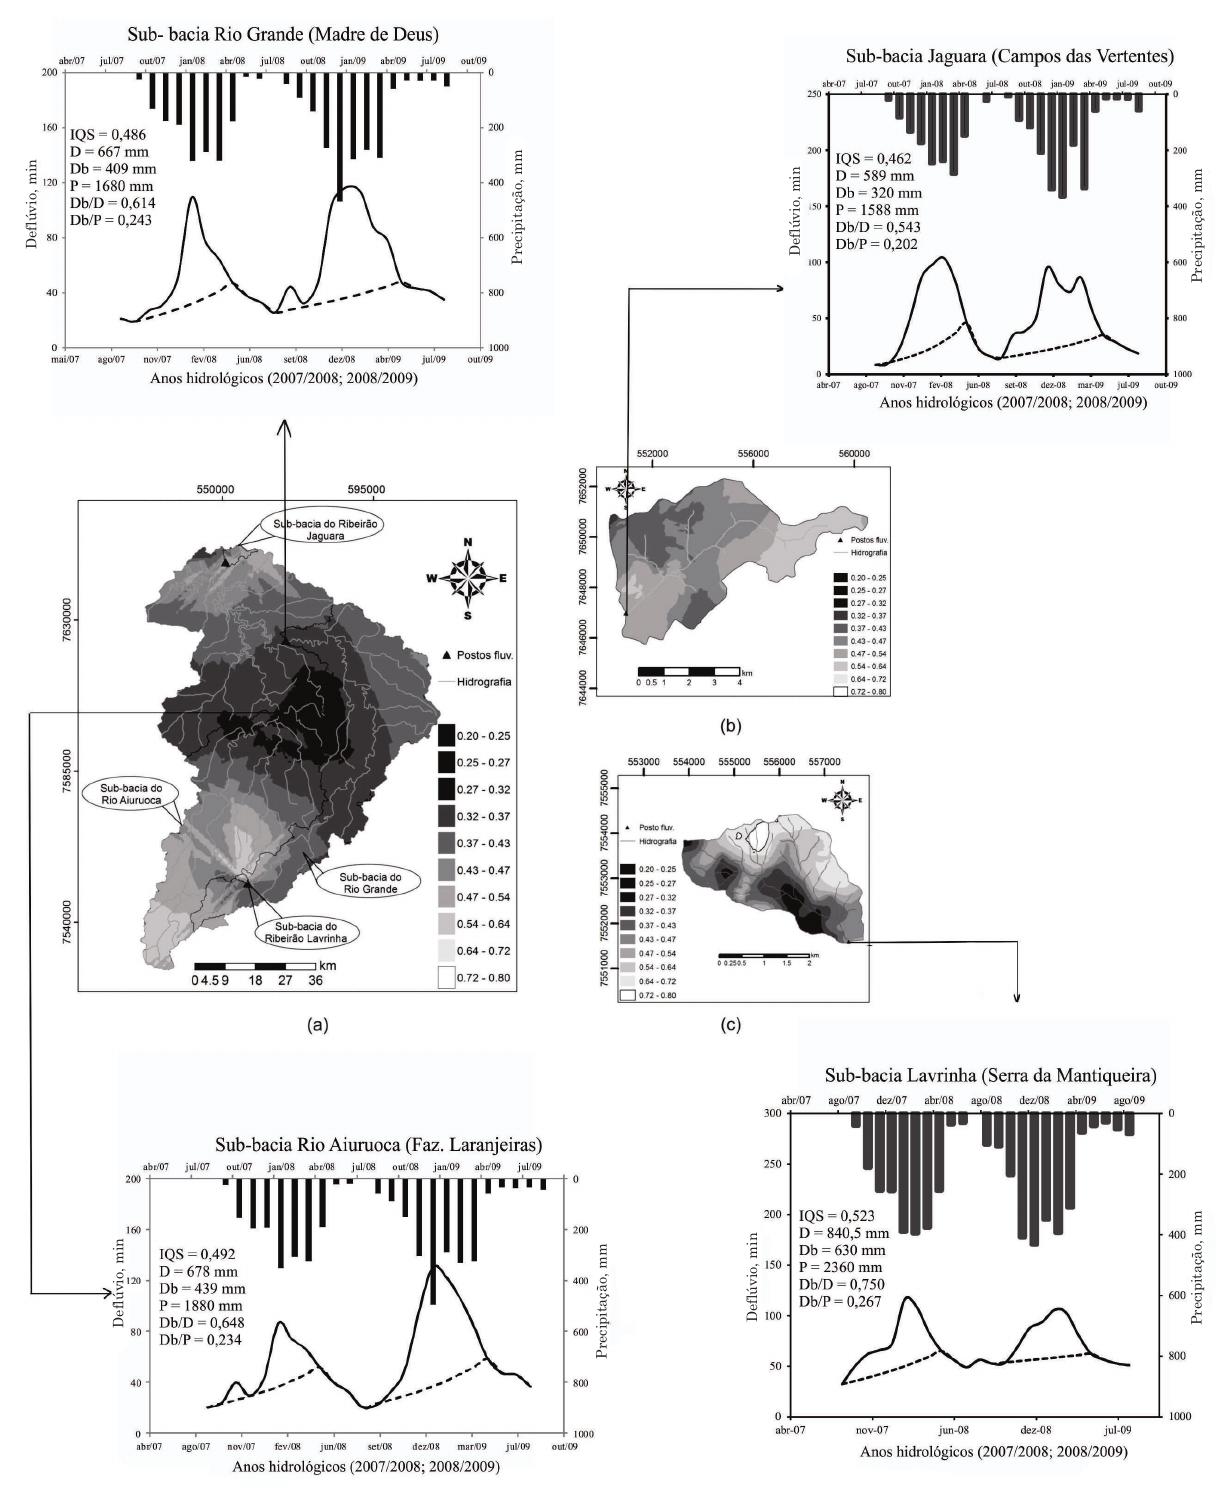
Figura 6. Distribuição espacial do índice de qualidade do solo associado à recarga subterrânea (IQS RA ) e apresentação de dados hidrológicos médios relativos aos anos hidrológicos de 2007/2008 e 2008/ 2009, para as sub-bacias hidrográficas dos rios Grande e Aiuruoca (a) e dos ribeirões Jaguara (b) e Lavrinha